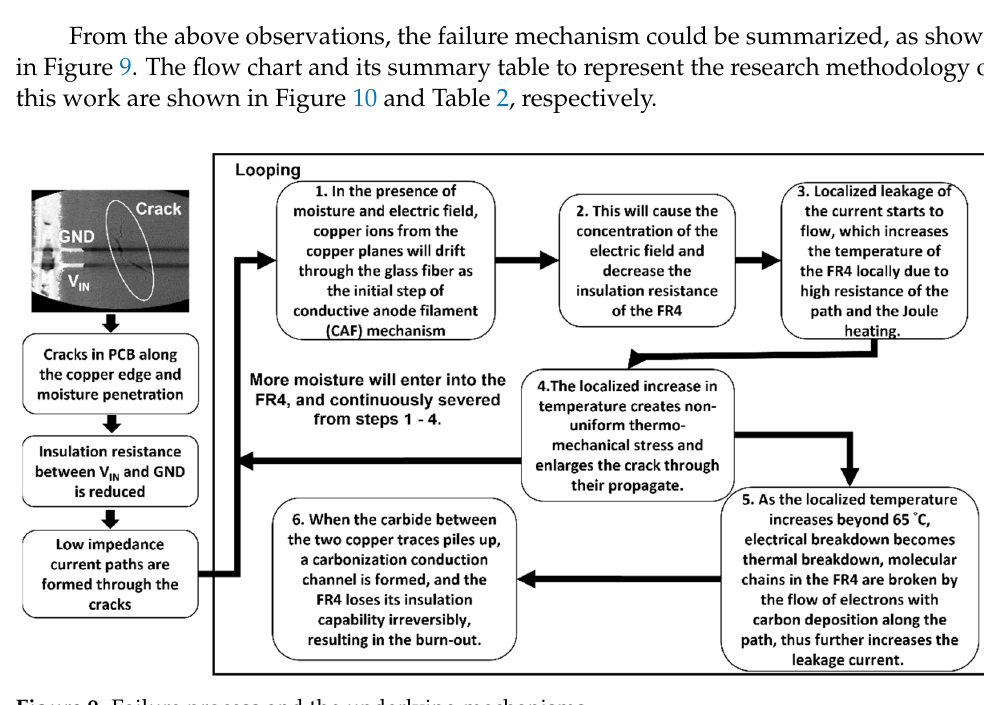
Figure 9. Failure process and the underlying mechanisms.